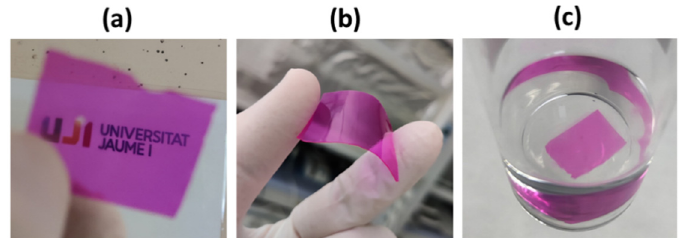
Figure 2. ( a , b ): pictures of a representative film of polymer A4 (size 30 × 25 mm 2 ) illustrating its transparency and flexibility; ( c ): picture of another film of polymer A4 (size 14 × 10 mm 2 ) immersed in water for four months, illustrating the absence of RB leaching. Table 1. Thermal properties of films A1 – A4 and B determined by TGA, and observed kinetic constant (average of three measurements) of the reaction of DMA with 1 O 2 generated by irradiation of the films.